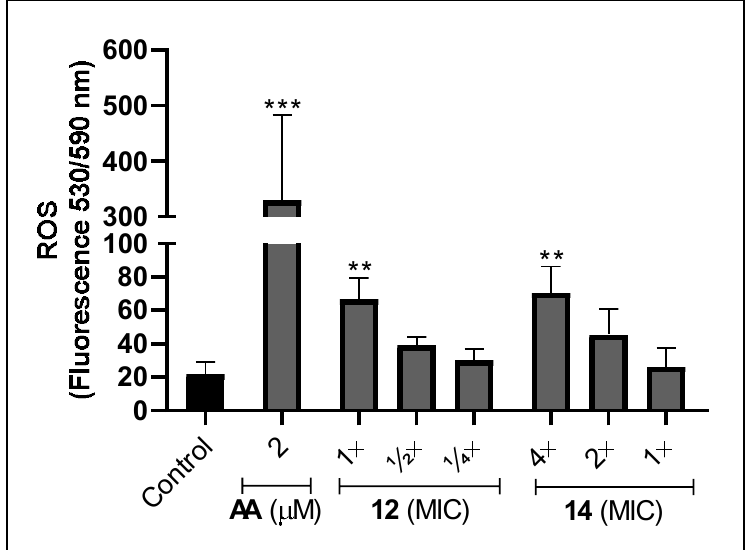
Figure 5. Conidia were incubated for 24 h at 26 °C in RPMI medium supplemented with distinct non-inhibitory concentrations of complexes 12 and 14. The resorufin fluorescence was determined using Amplex™ Red Hydrogen Peroxide/Peroxidase Assay Kit and detected after reading in the fluorimeter. Antimycin A (AA) was used as positive control. ** p < 0.01, *** p < 0.001.